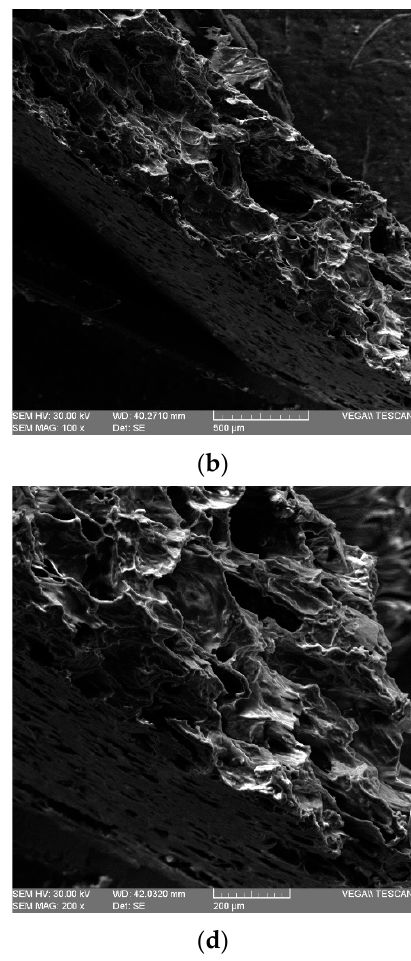
Figure 2. Wafer microstructure by scanning electron microscopy (SEM) of control sample and spent grain sample.( a ) Control sample at magnification 100×; ( b ) Spent grain sample at magnification 100×; ( c ) Control sample at magnification 200×; ( d ) Spent grain sample at magnification 200×.